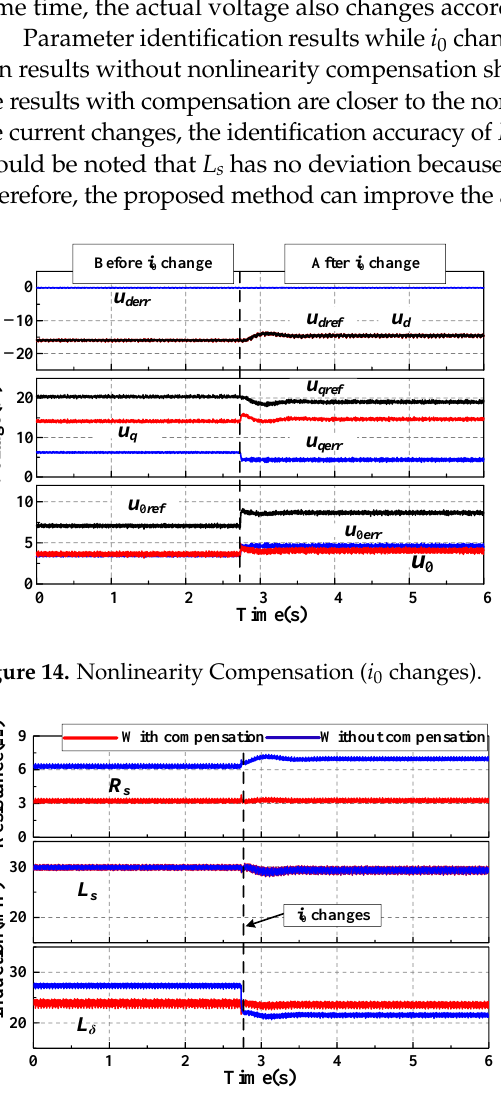
Figure 15. Results of parameter identification ( i 0 changes).